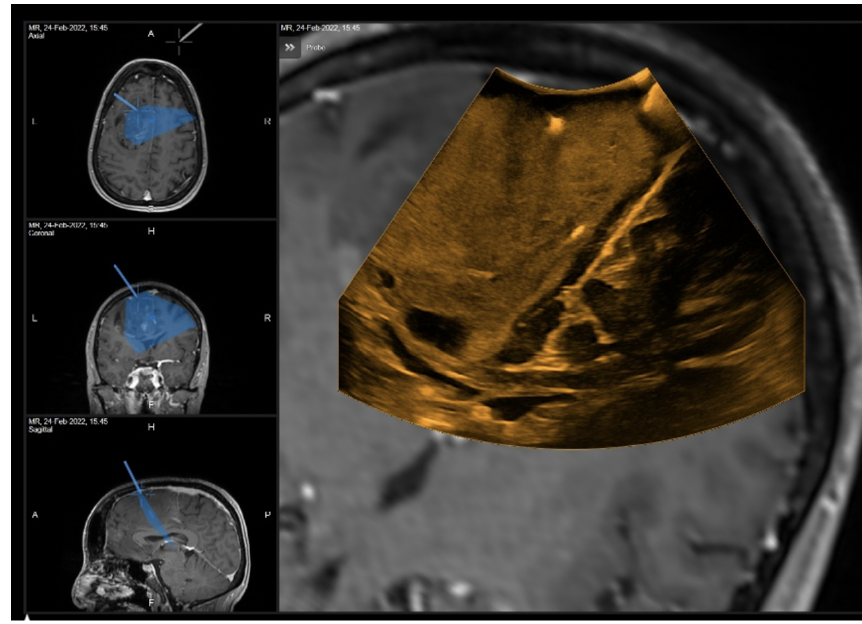
Figure 8. 2D iUS scan after dura opening.